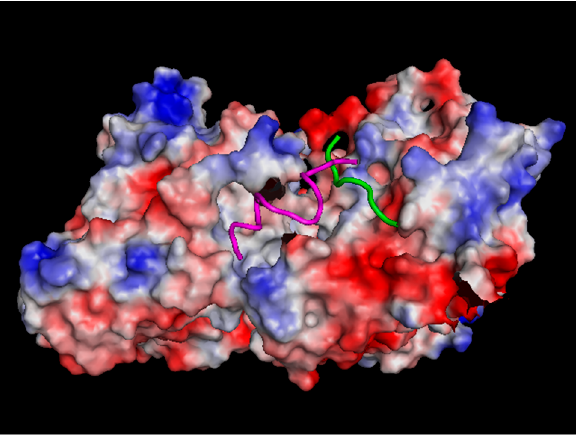
Figure 2. A cross-linked conformation of C-termini stabilizes a straight orientation of a tubulin dimer. A disruption of this conformation can cause MT instability.